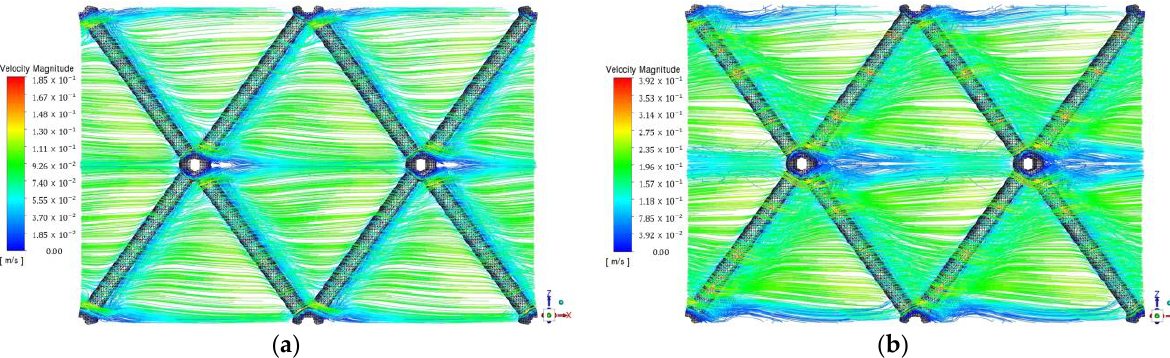
Figure 2. Detailed view of the fluid path lines for channel-gap reduction h/D = 0.10, at different Re numbers; ( a ) Re = 67, ( b ) Re = 149.